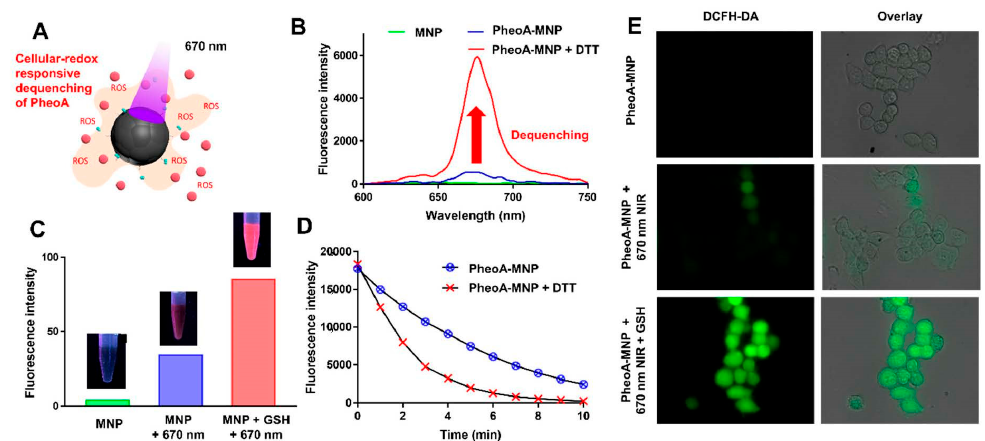
Figure 3. ( A ) Illustration of PheoA-MNPs within the mechanism of photodynamic therapy (PDT). ( B ) The fluorescence emission spectra of PheoA-MNPs before (blue) and after (red) incubation with dithiothreitol (DTT). Red arrow stands for dequenching of PheoA. ( C ) The fluorescence intensity of HCT 116 cells treated with PheoA-MNPs in the presence and absence of light irradiation (670 nm) and / or the GSH-Oet. ( D ) Change in dimethylanthracene (DMA) fluorescence due to the generation of singlet oxygen by PheoA-MNPs treated with or without DTT. ( E ) The confocal laser scanning microscope (CLSM) images of HCT 116 cells treated with PheoA-MNPs in the presence of light irradiation (670 nm) and the GSH-Oet.